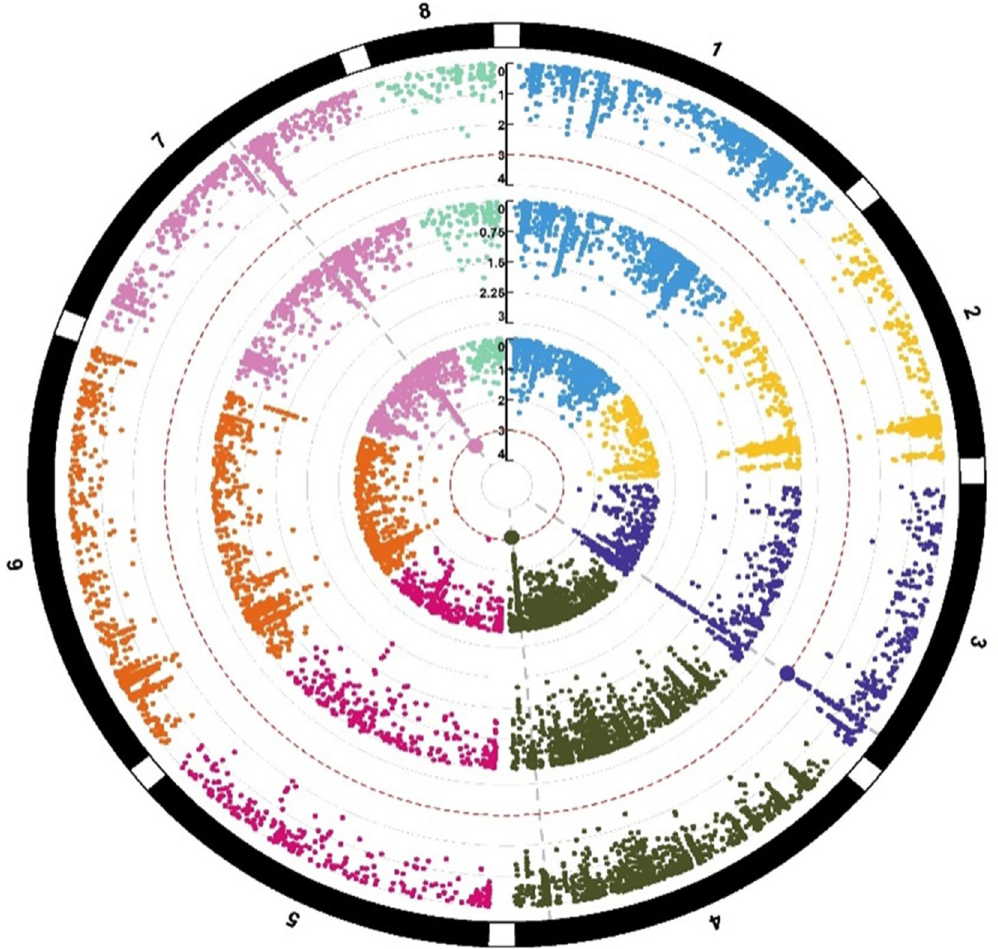
Figure 6. Circular Manhattan plots of showing marker-trait associations (MTAs) for seed Mn concentrations. The eight different colors represent 8 different chickpea chromosomes. The three concentric circles (each having 8 colors) shows MTAs identified for seed Mn concentrations in two environments and data pooled over